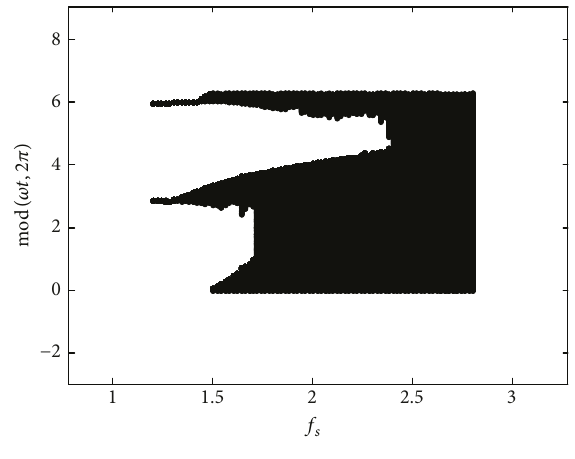
Figure 6: Sliding time bifurcation diagram.